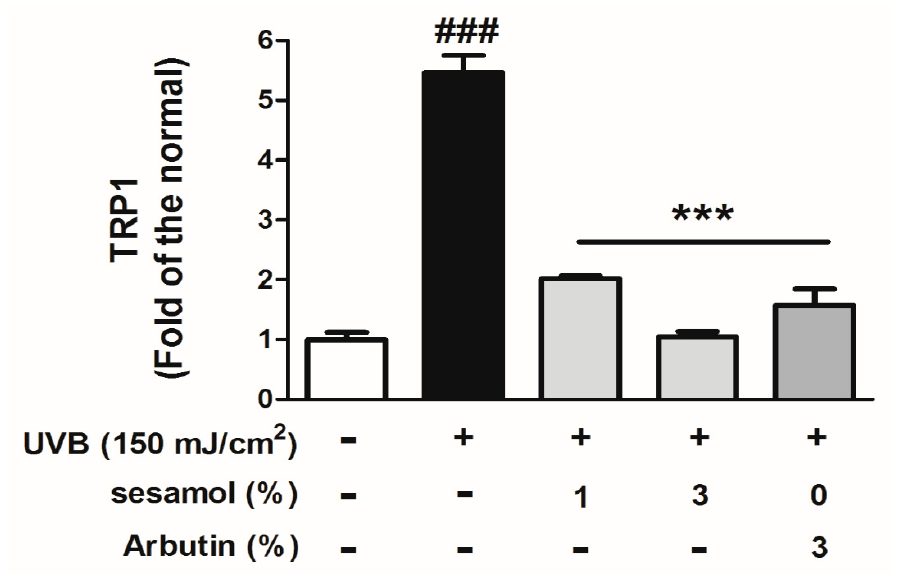
Figure 10. Light micrographs of histological sections stained with tyrosinase-related protein-1 (TRP-1) in UVB-irradiated C57BL/6 mice that received topical application of sesamol once a day to the ear skin. The TRP-1 level increased in the UVB-irradiated group, whereas topical application of sesamol reduced the effect. (Significant difference versus control: ###, p < 0.001. Significant difference versus UVB treated group: ***, p < 0.001.).